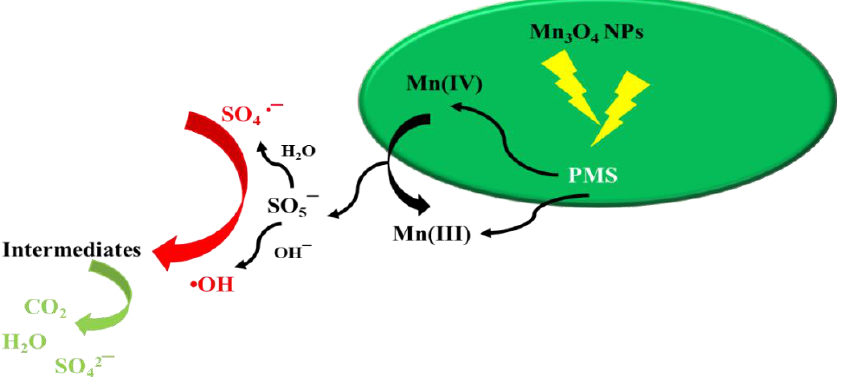
Figure 9. Schematic mechanism of PMS activation by Mn 3 O 4 catalyst.